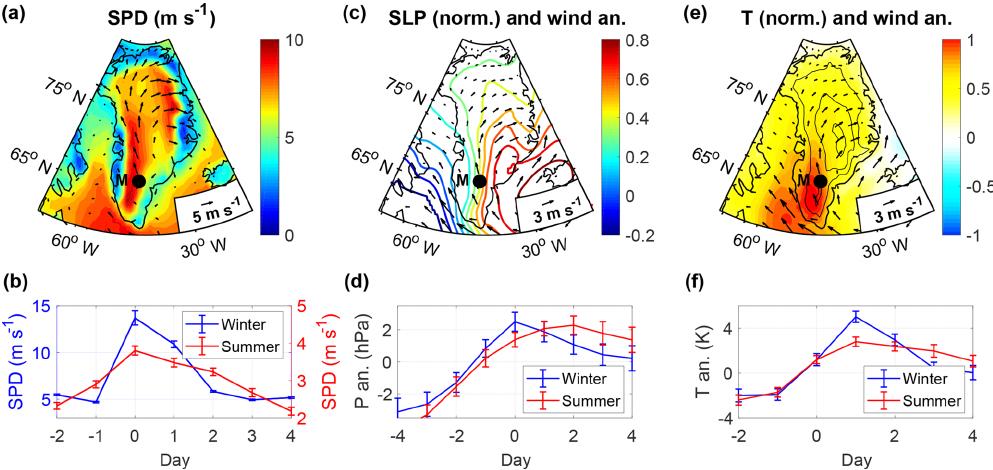
Figure 3. Composites of (a) the 10m wind speeds (SPD) and the normalized (c) sea level pressure and (e) temperature anomalies during melt events (at day 0 in Fig. 1d), obtained from ERA-I. Normalized implies that the climatological monthly means are subtracted and the result is divided by the standard deviation. Composites of (b) wind speed and (d) pressure and (f) temperature anomalies at Station Saddle (M), where the anomalies are with respect to the mean during the events. Error bars represent the standard error of the mean.